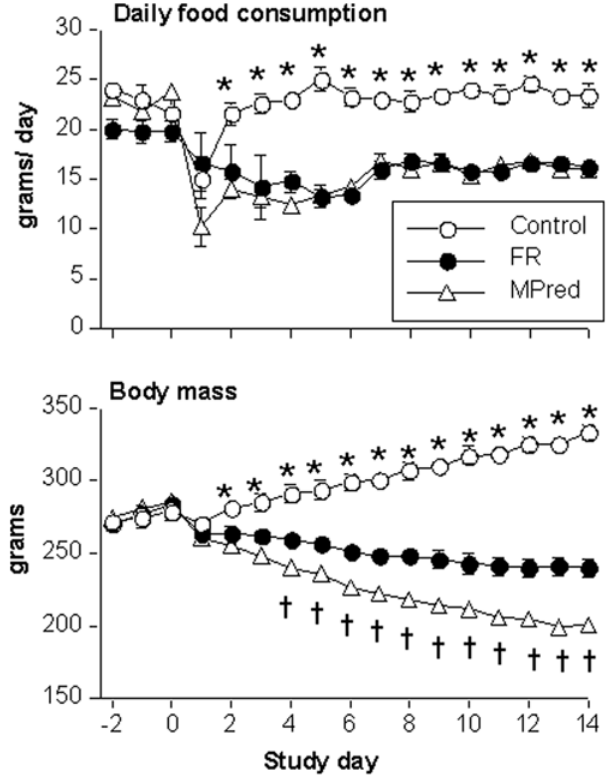
Figure 1. Daily food consumption and body mass (mean 6 SEM). FR, food restricted group; MPred, methylprednisolone group. * Control higher than MPred and FR, P , 0.05 , { MPred less than FR, P , 0.05